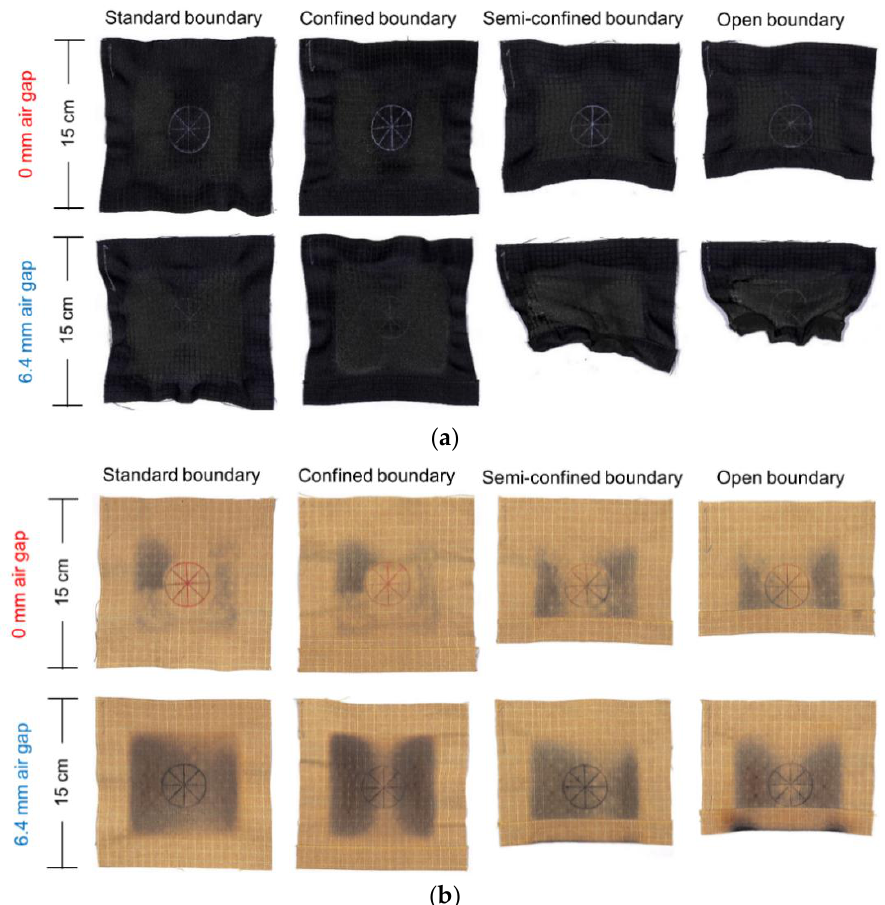
Figure 7. Backside photographs of the specimens after fire exposure under the heat flux of 50 kW / m 2 : ( a ) Nomex IIIA specimens. Thermal shrinkage was more severe in the presence of air gap for semiconfined and open boundary conditions; ( b ) Kevlar / PBI specimens. No significant thermal shrinkage of the specimens, while the area of color fading and carbonization is valid evidenced of the e ff ect of air